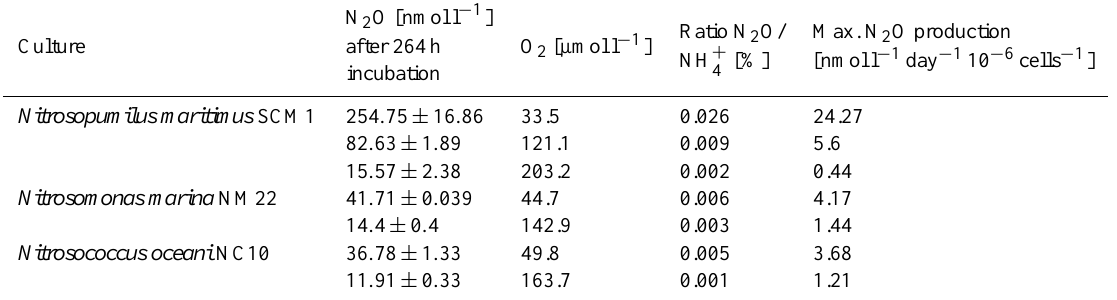
Table 2. N 2 O production in culture experiments: mean O 2 and N 2 O concentrations (in triplicate samples) of pure cultures of N. maritimus , N. marina and N. oceani after 264h incubation, the initial NH + concentration ( ∼ 1mmoll − 1 ) was completely converted to NO − 4 of the experiment in AOB cultures, NO − was below the detection limit at the initial time point of the 2